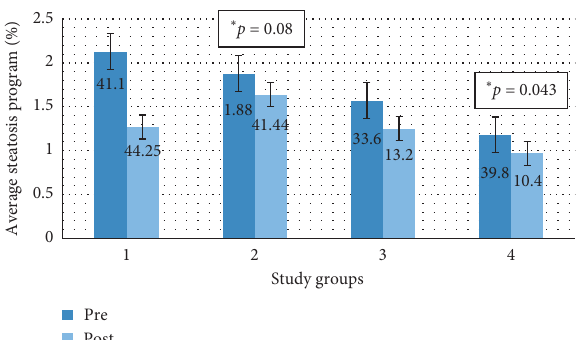
Figure 9: Percentage of average pre-post steatosis (program) by study groups. Group 1: animals that maintained a steatotic diet and received concomitant treatment. Group 2: animals that maintained a steatotic diet and received no drug. Group 3: animals that did not continue with the steatotic diet but received melatonin treatment. Group 4: animals that did not continue with the steatotic diet and did not receive any drug.